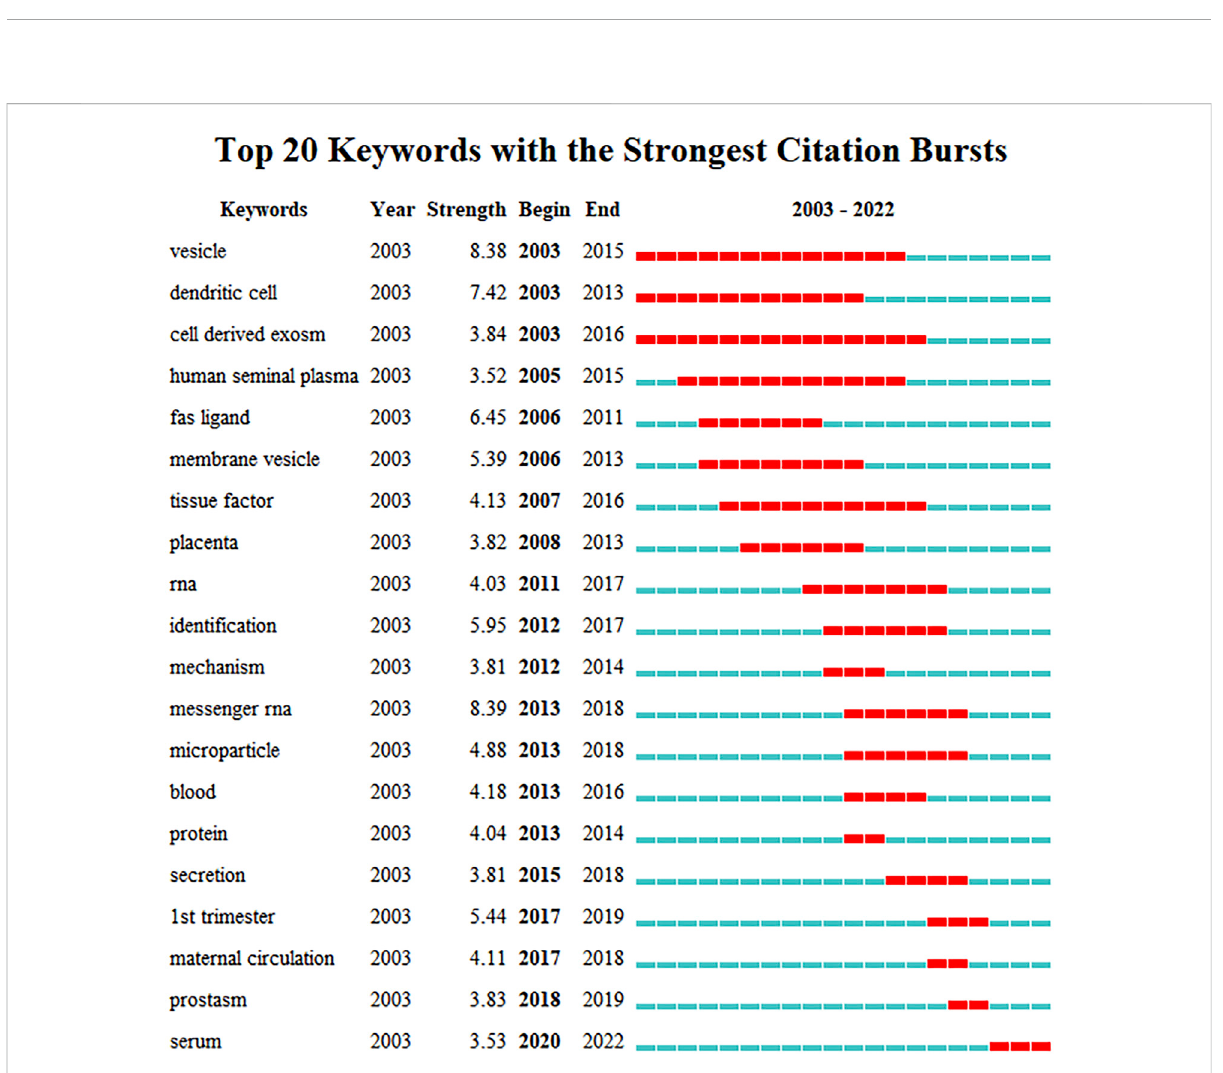
FIGURE 8 Burst word analysis of keywords to research on exosomes in